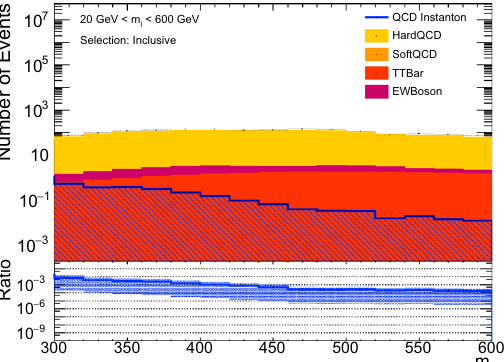
(cid:8) luminosity of L = 1pb − 1 and the distributions from all processes except the Instanton process are stacked. The model uncertainties are indicated as bands. The lower plots show the signal over background ratio corresponding to the upper row